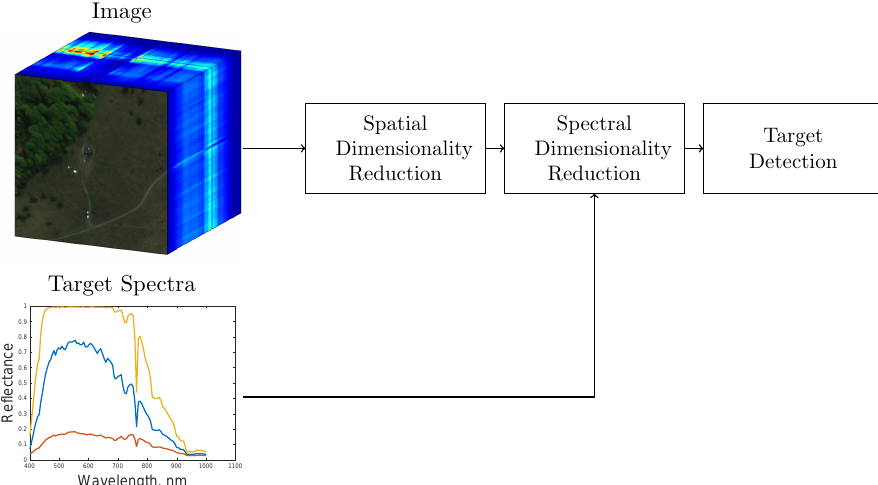
Figure 2. Spatio-spectral dimensionality reduction pipeline for target detection.